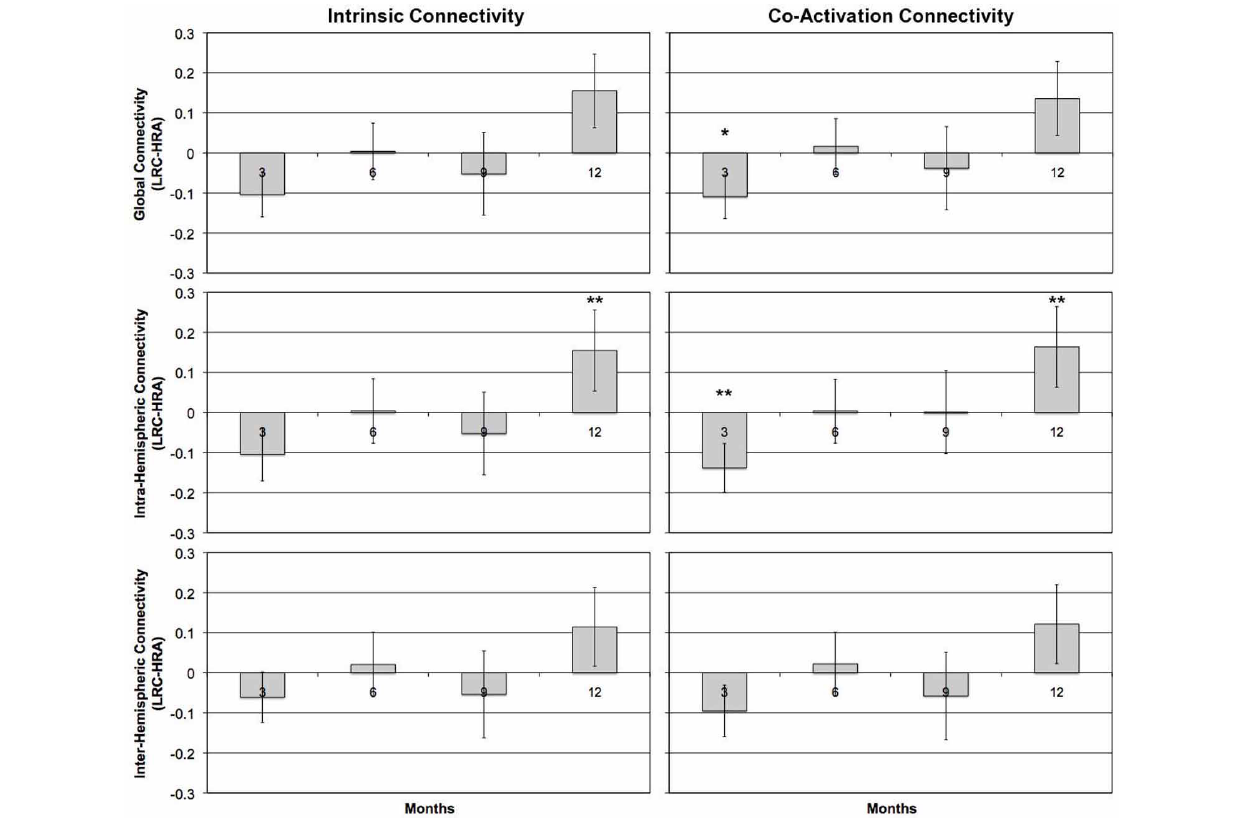
co-activation (right column) connectivity pipelines. Positive scores reflect LRC > HRA; negative scores reflect HRA > LRC for connectivity measures. Error bars represent one standard error of the mean. ∗ p < 0 . 1, ∗∗ p < 0 .